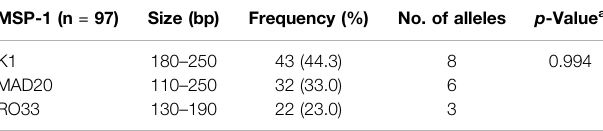
TABLE 1| Genotypingof Plasmodiumfalciparummsp-1 inKhyber Pakhtunkhwa.